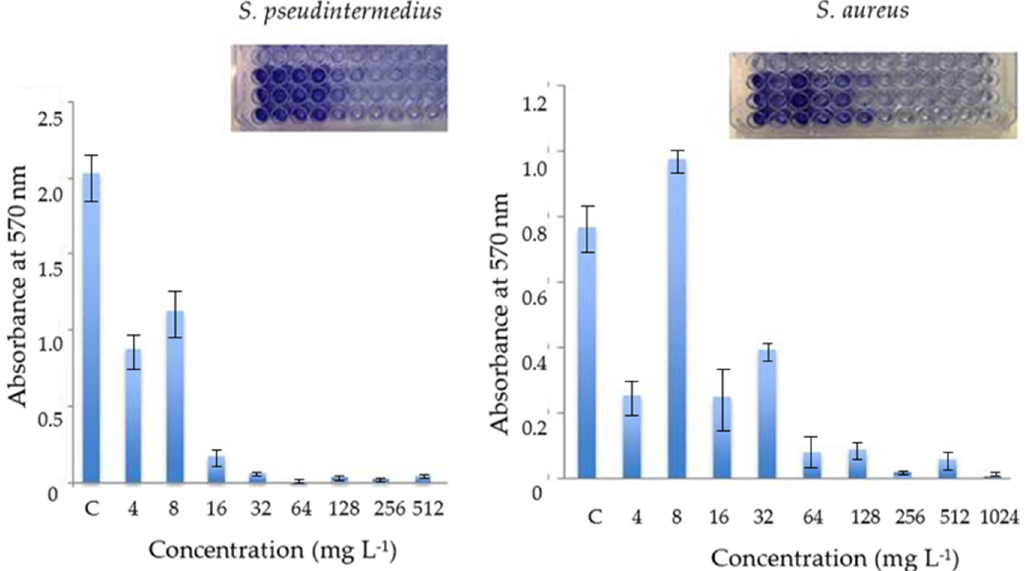
Figure 4. Effect of DHAB on the formation of biofilms in vitro by S. pseudintermedius and S. aureus . Data are means ± standard deviations of three independent determinations.